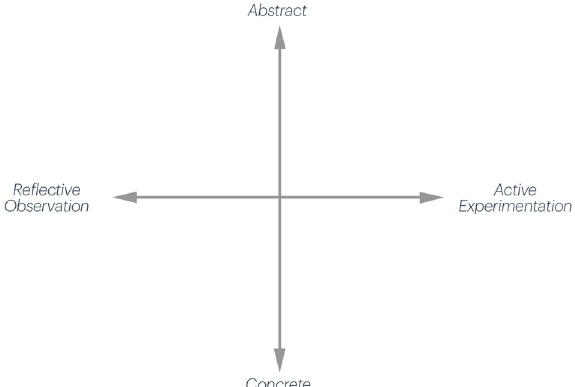
Fig. 1 Kolb Learning model as adapted from Beckman and Barry (2007), Kolb (1984) and Kolb and Kolb